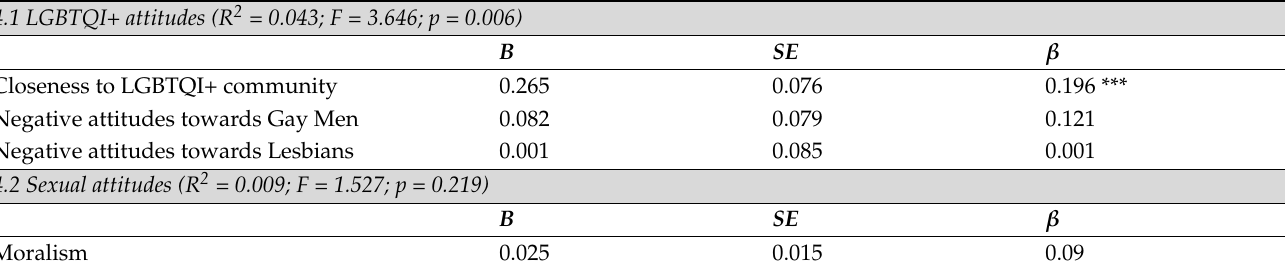
Table 6. Hierarchical multiple regression analyses on LGBTQI+ and sexual attitudes (n =